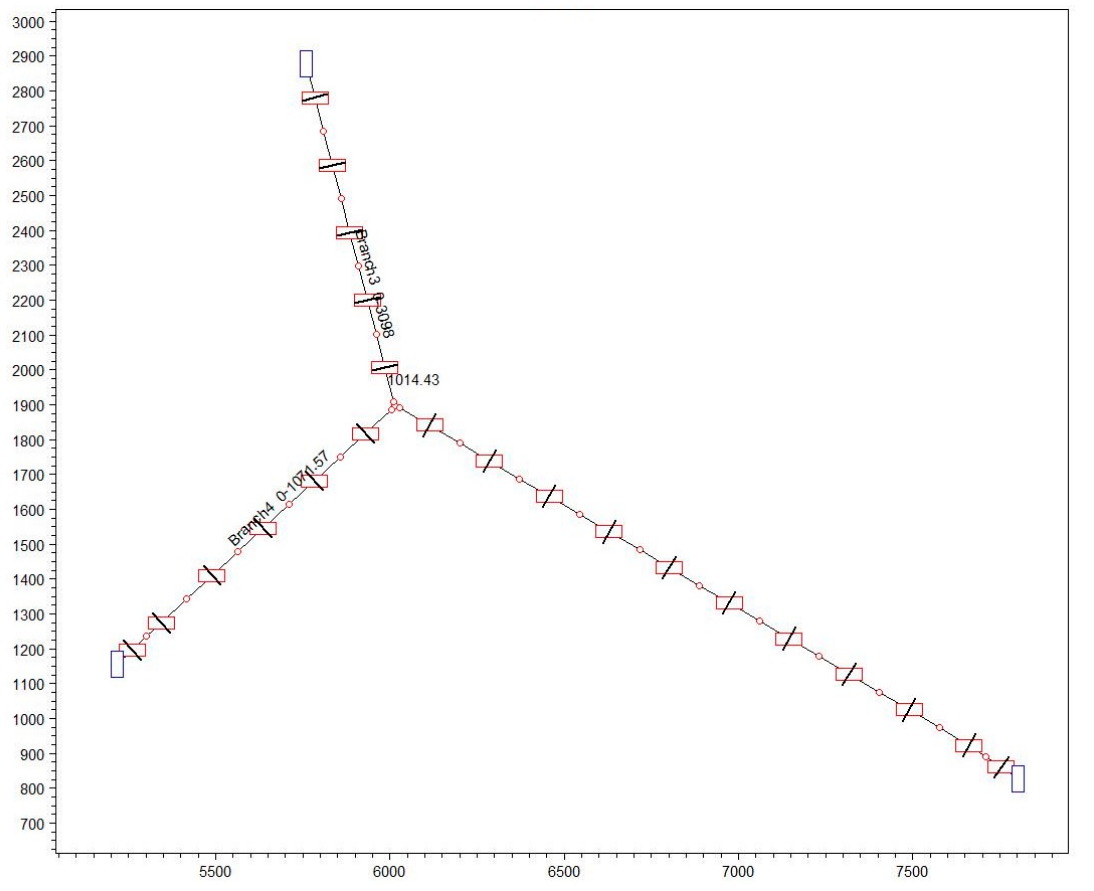
Figure 8. Simple bifurcation with different cross-section spacing.